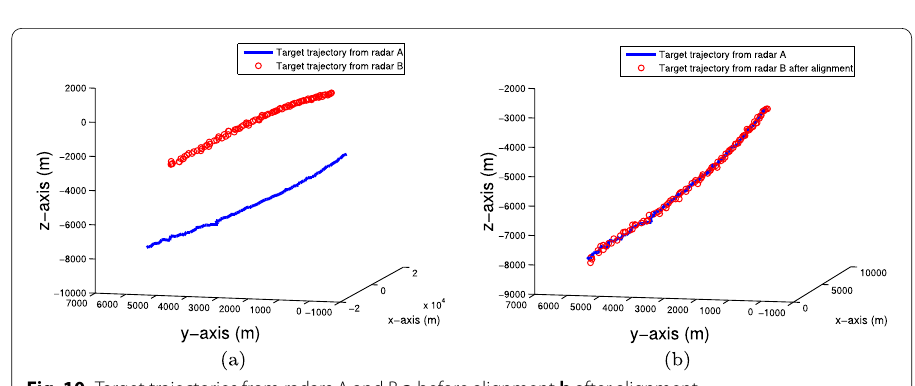
Fig. 10 Target trajectories from radars A and B a before alignment b after